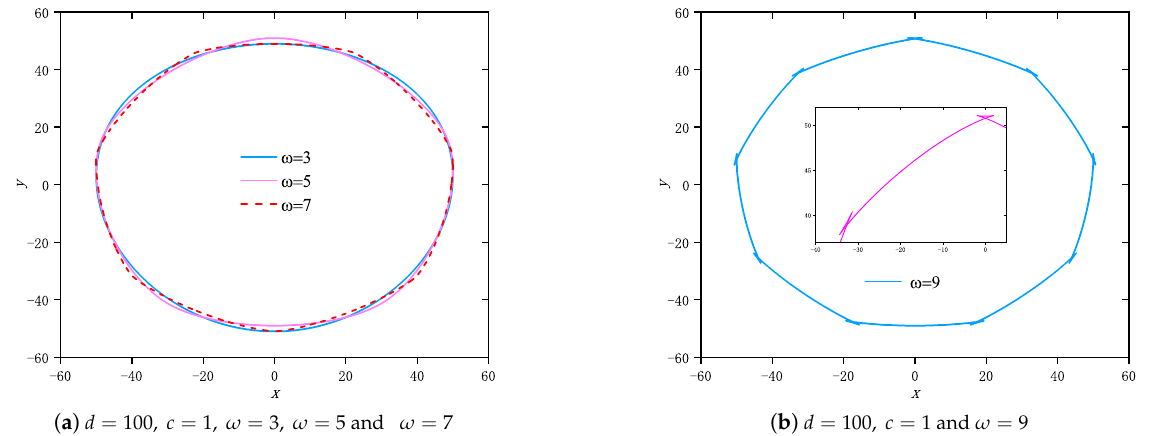
( a ) d = 100, c = 1, ω = 3, ω = 5 and ω = 7 ( b ) d = 100, c = 1 and ω = 9 Figure 1. Trajectory curves of (20) with different ω .